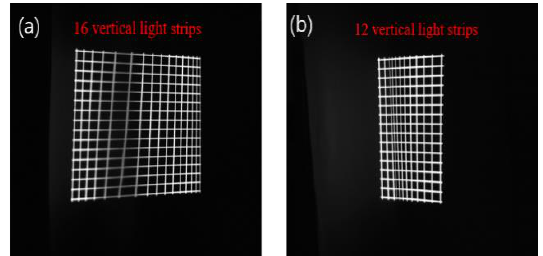
Figure 10. The acquired images with depth variations in a target scene. ( a ) The image with all light stripes when the monotonicity constraint was satisfied; ( b ) The image with light strip loss during measuring depth changes over the upper bound.